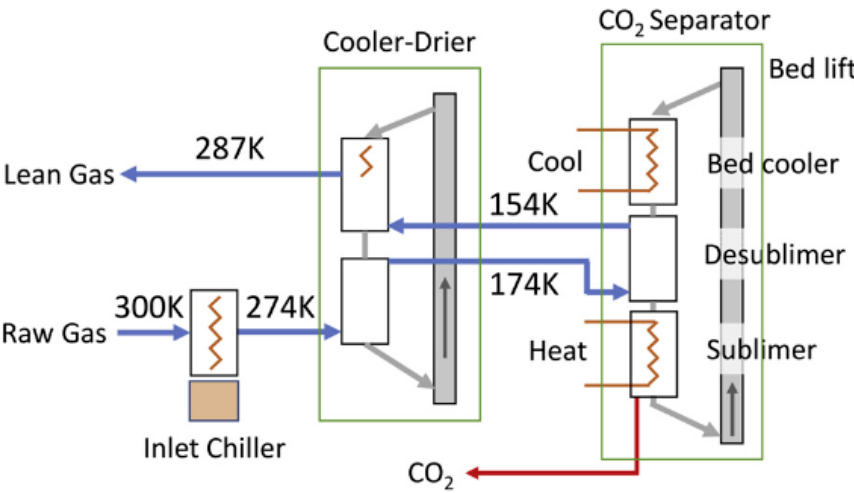
Figure 1. Sketch of the A3C moving bed process [10].